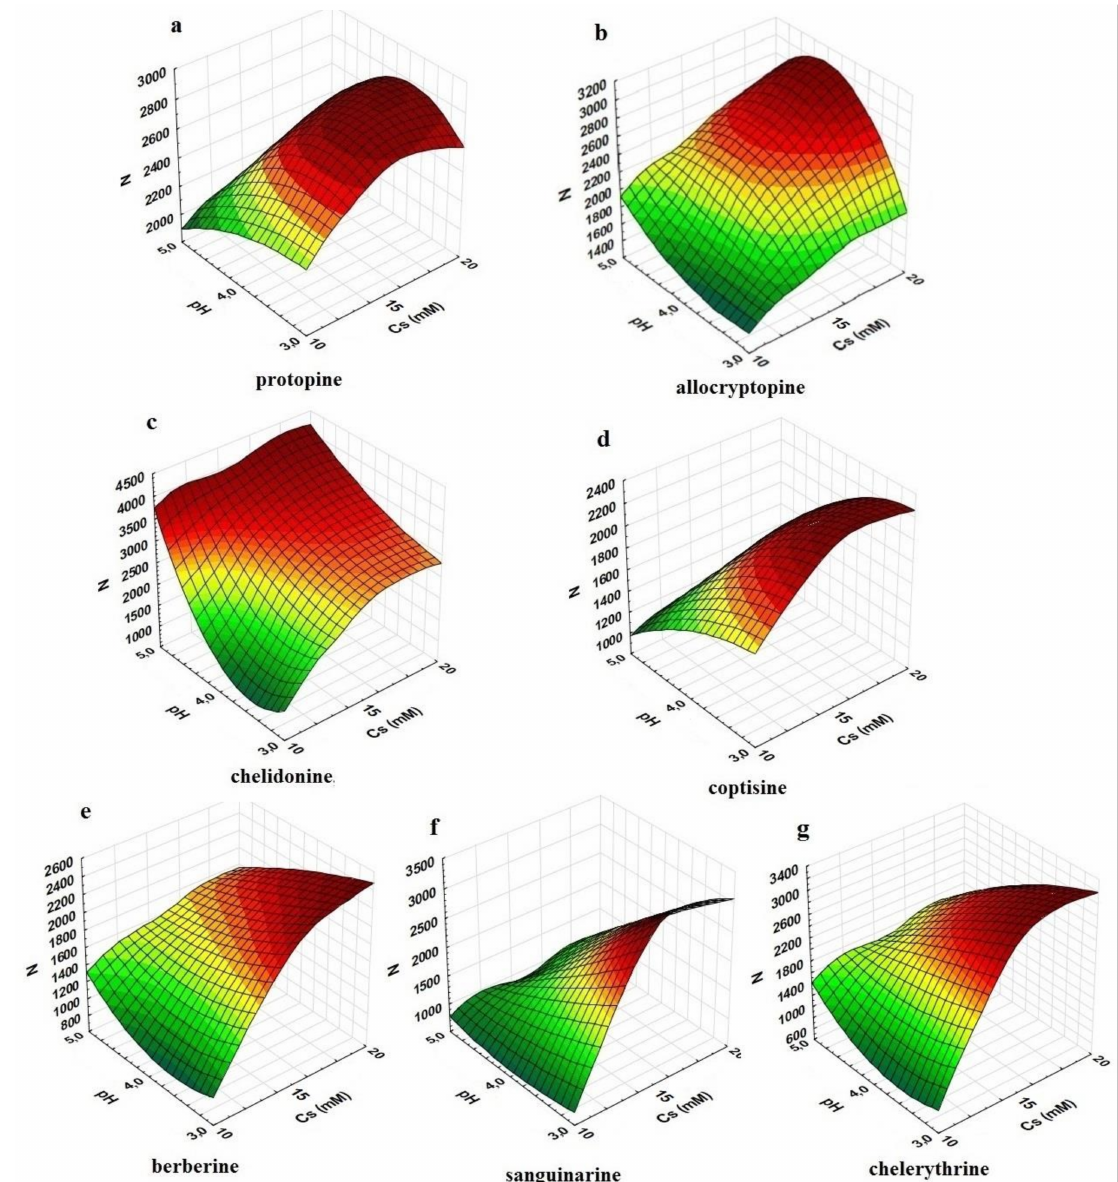
Figure 2. Relationship between the e ffi ciency of the chromatographic system (N), the pH of the eluent, and ammonium acetate concentration in the mobile phase, which was composed of water and acetonitrile (8:2, v / v ): ( a )—protopine; ( b )—allocryptopine; ( c )—chelidonine; ( d )—coptisine; ( e )—berberine; ( f )—sanguinarine; ( g